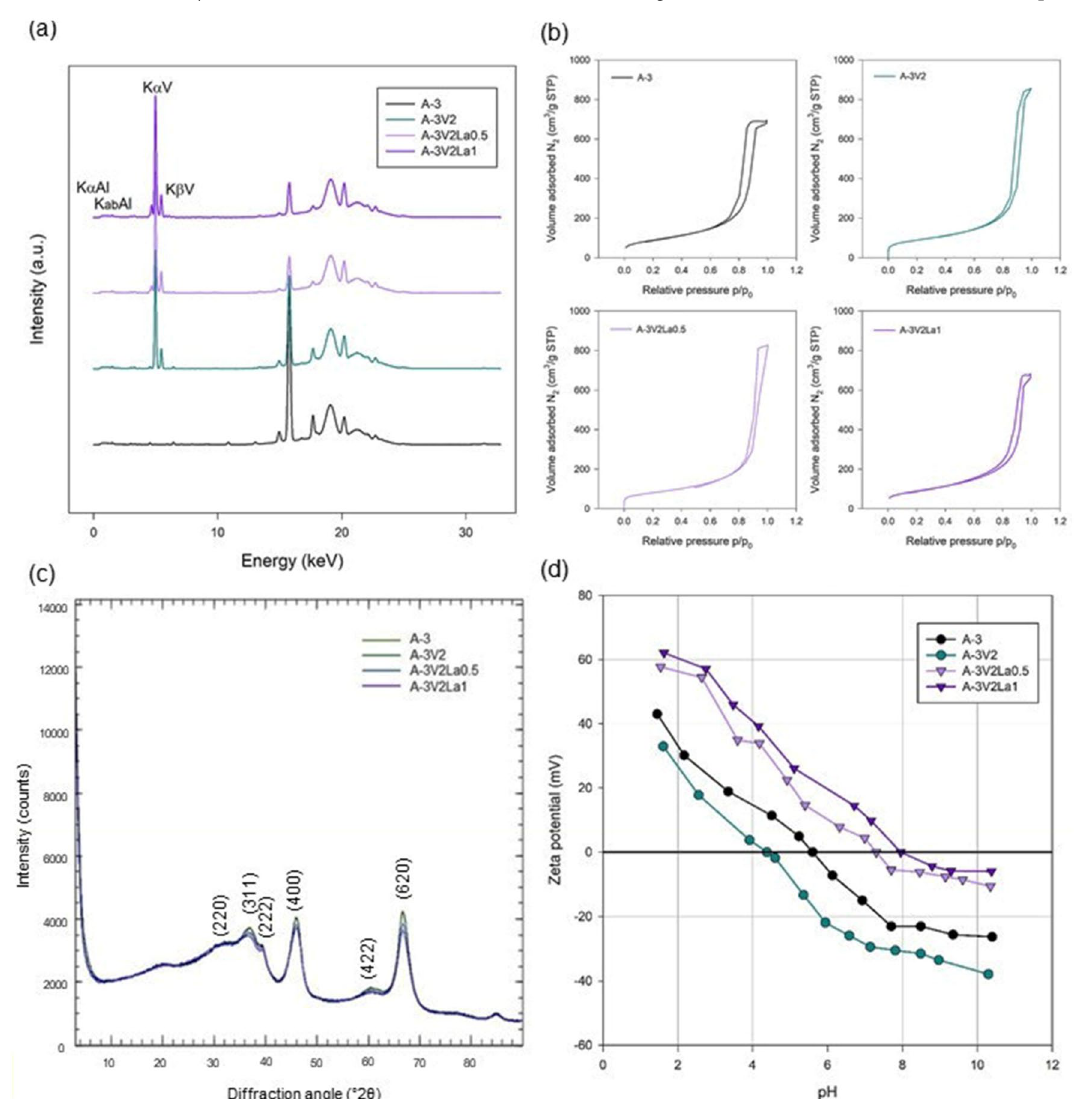
Figure 4. XRF spectra ( a ), adsorption–desorption isotherms ( b ), XRD patterns ( c ), and graphs of zeta potential vs. pH ( d ) obtained for samples A-3, A-3V2, A-3V2La0.5 and